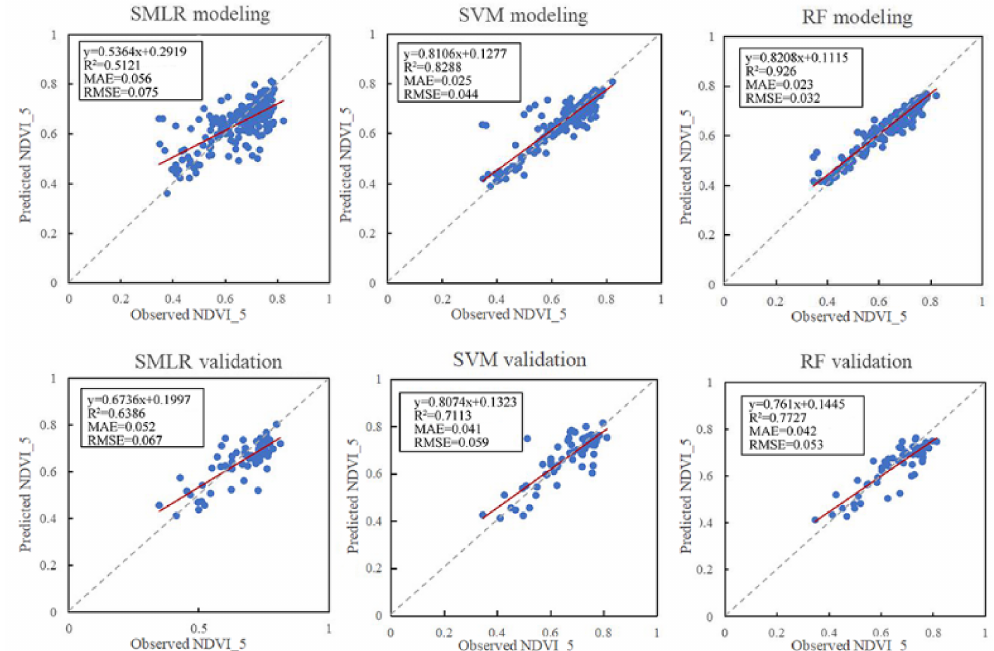
Figure 6. The fitting and validation results of the support vector machine (SVM), random forest (RF), and stepwise multiple linear regression (SMLR) ( P <